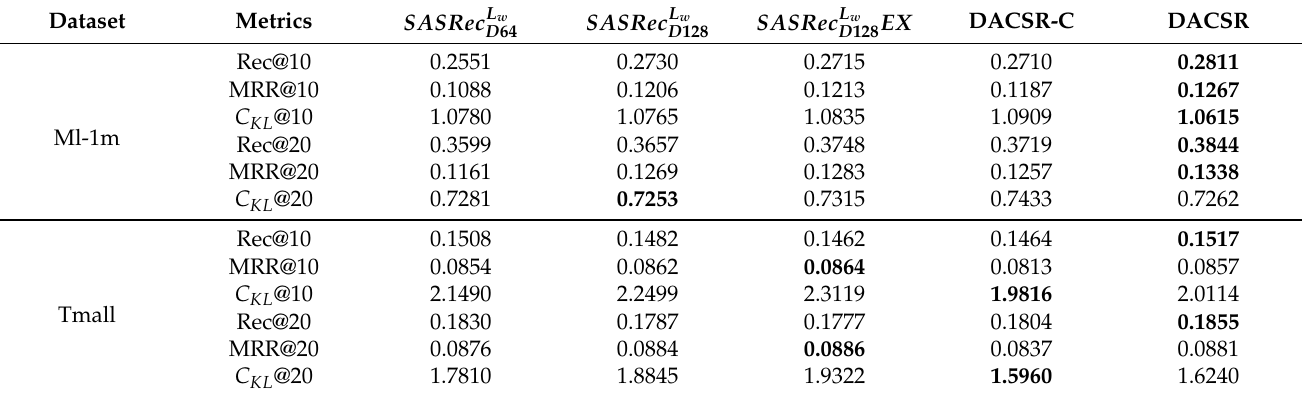
Table 5. Performance comparisons between our DACSR model and its